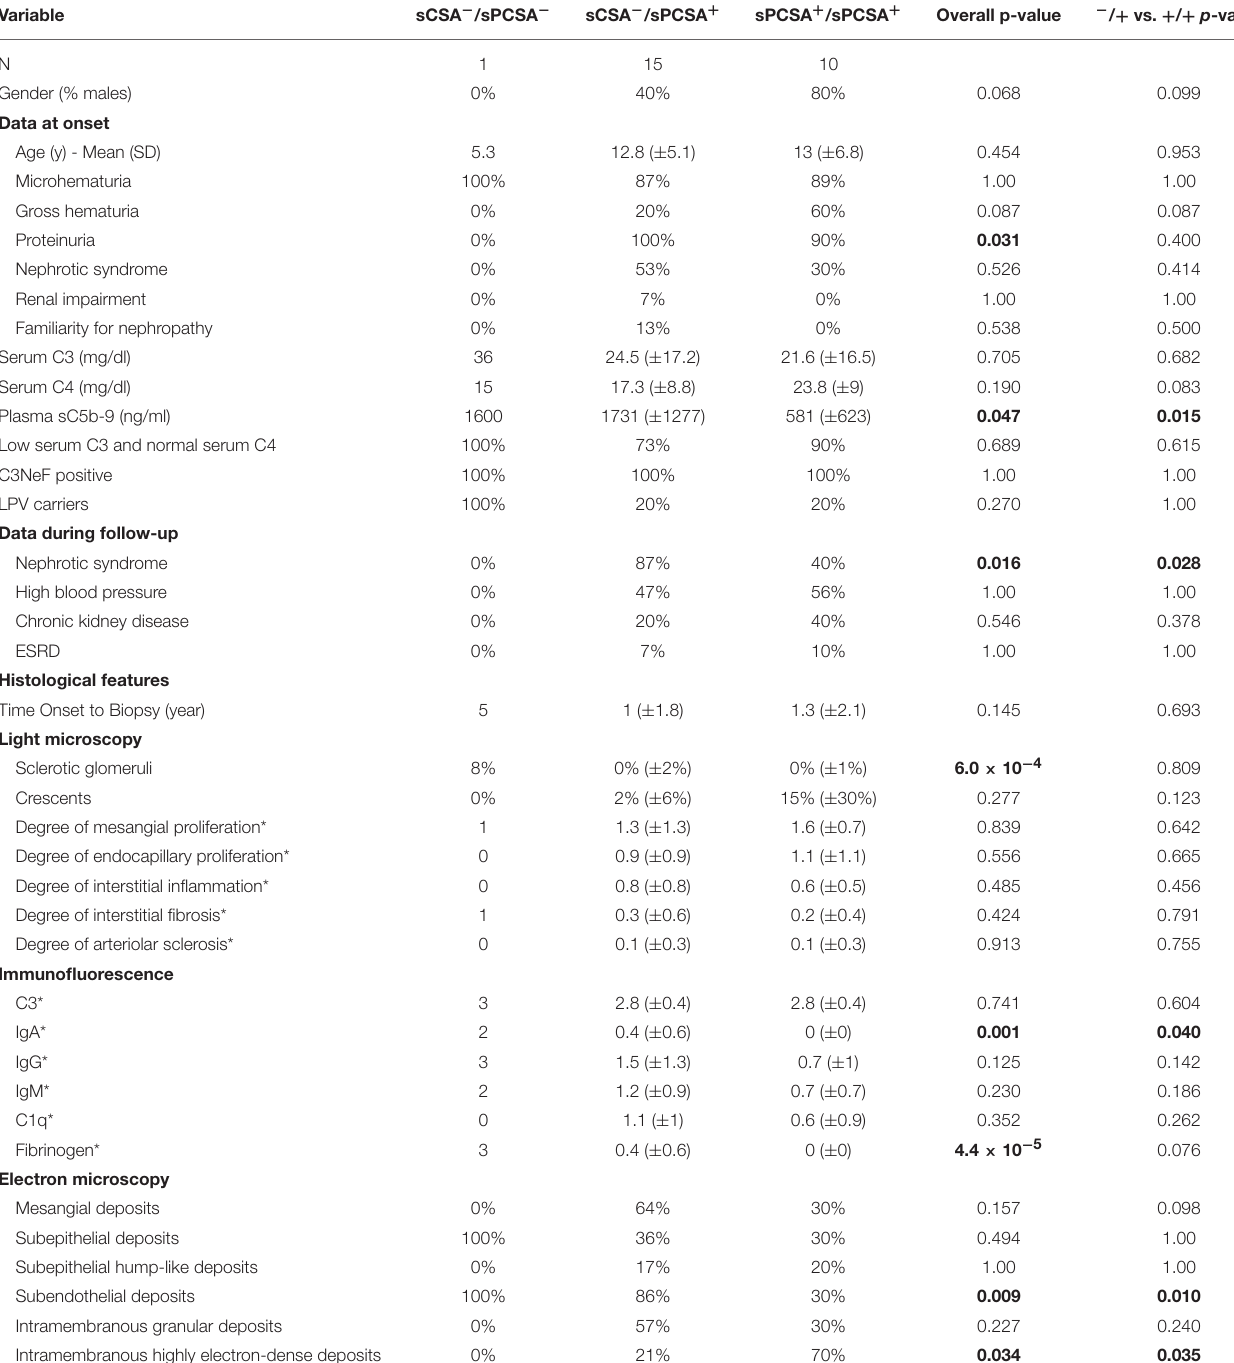
TABLE 5 | Clinical features, complement assessment, genetic screening and histologic features in patients classified according to the type of C3 convertase stabilizing activity (spontaneous decay).